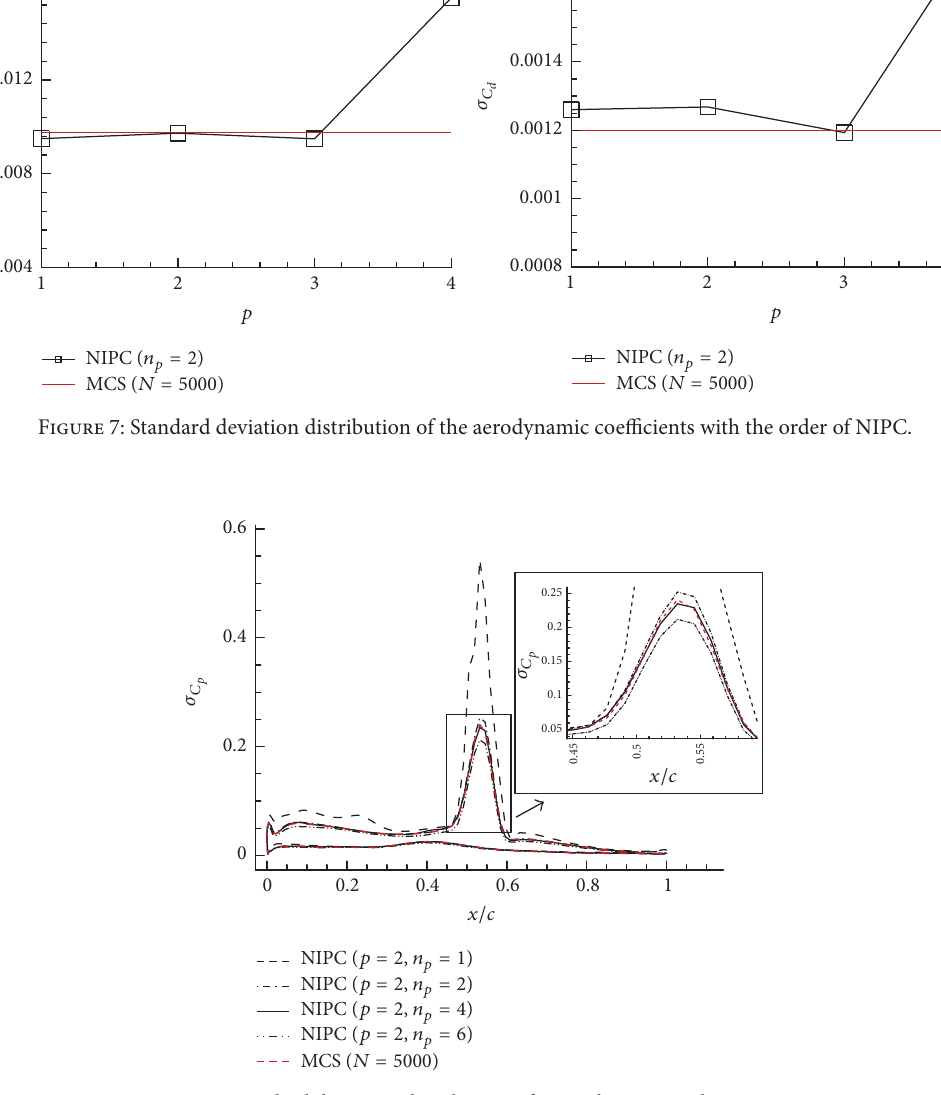
Figure 8: Standard deviation distribution of 𝐶 𝑝 with oversampling ratio 𝑛 𝑝